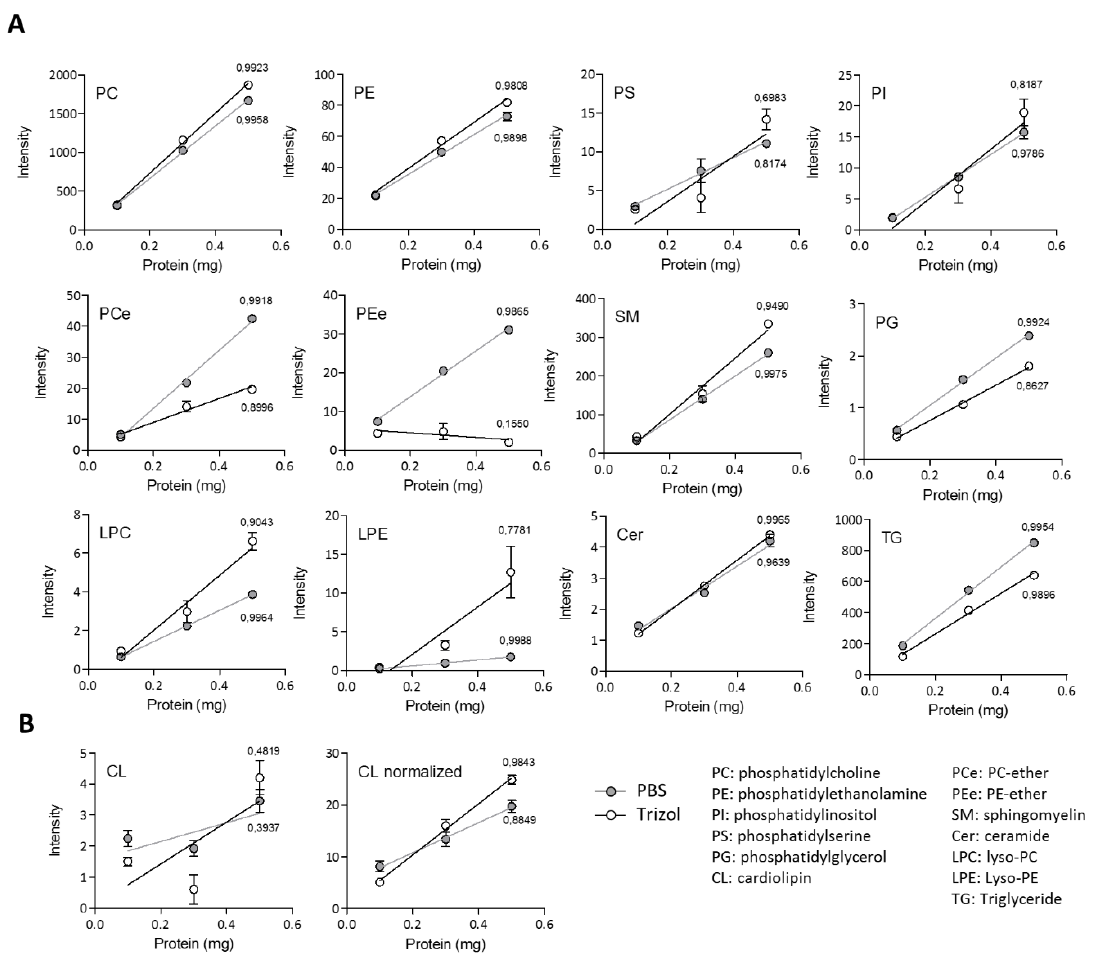
Figure 1. Lipid class intensity detected by UHPLC-MS after lipid extraction from Trizol or PBS homogenates of kidney. ( A ) Values represent the sum of intensities of lipid species of each lipid class; ( B ) values corresponding to CL are represented as in ( A ) and normalized with intensity of the internal standard included before lipid extraction (Cardiolipin Mix I from Avanti Polar Lipids). Values are plotted against the protein quantity of kidney homogenates used for lipid extraction. R 2 values for each linear regression analysis are shown next to each line. Only classes with more than 5 molecular species identified have been considered for this analysis. 2 (0.1 mg of protein) or 3 (0.3 and 0.5 mg of protein) homogenates were used for lipid extraction and data are shown as the mean ± SEM.